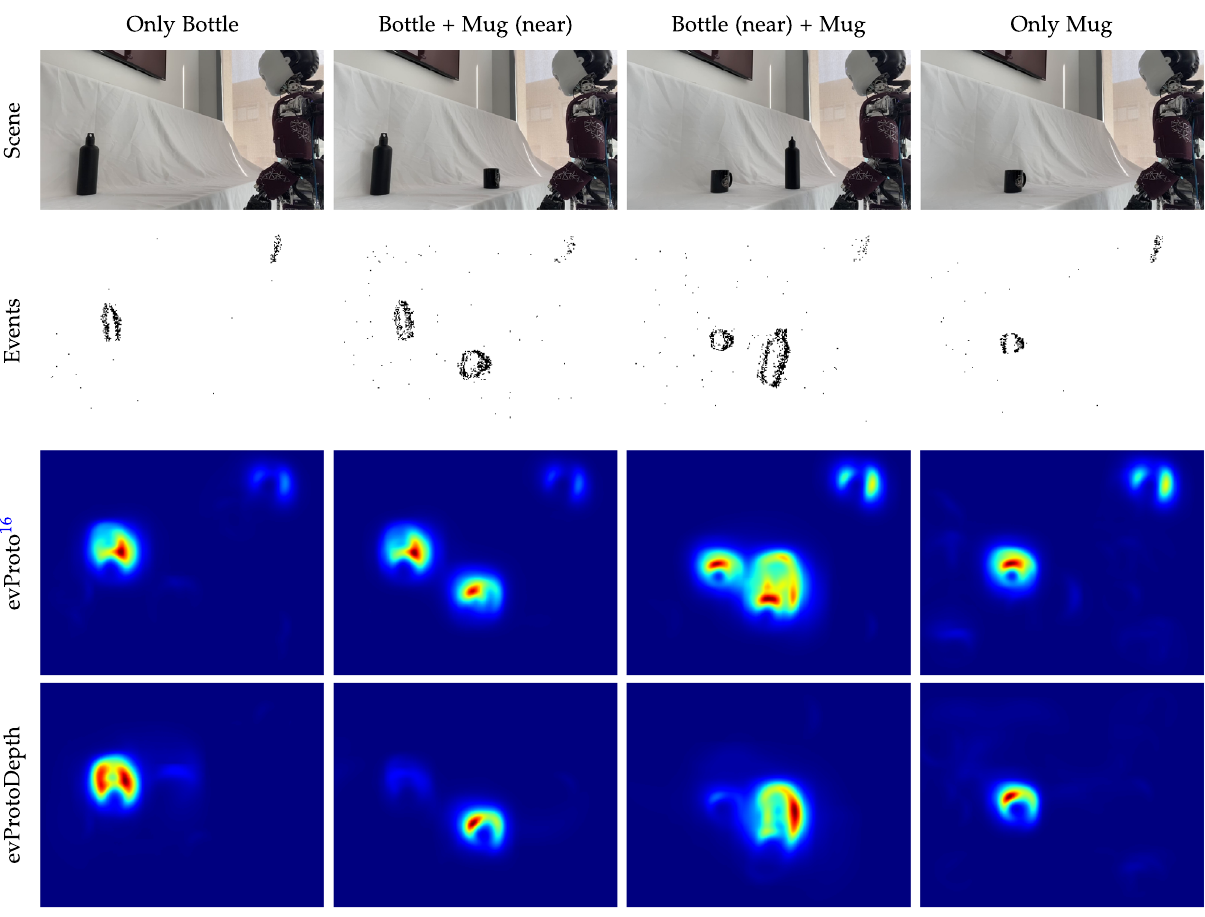
Figure 5. Static objects at changing depth (bottle-mug) dataset. The columns show snapshots from the 4 different configurations in the dataset. Row 1 depicts the scene from a third perspective. Row 2 shows the event images accumulated over 100 ms. Row 3 and 4 illustrate the output generated by the evProto and the evProtoDepth models respectively. Each plot shows the 2D histogram of saliency maps accumulated over all frames in a single input configuration. Object selection is more stable with the 3D model in the presence of multiple